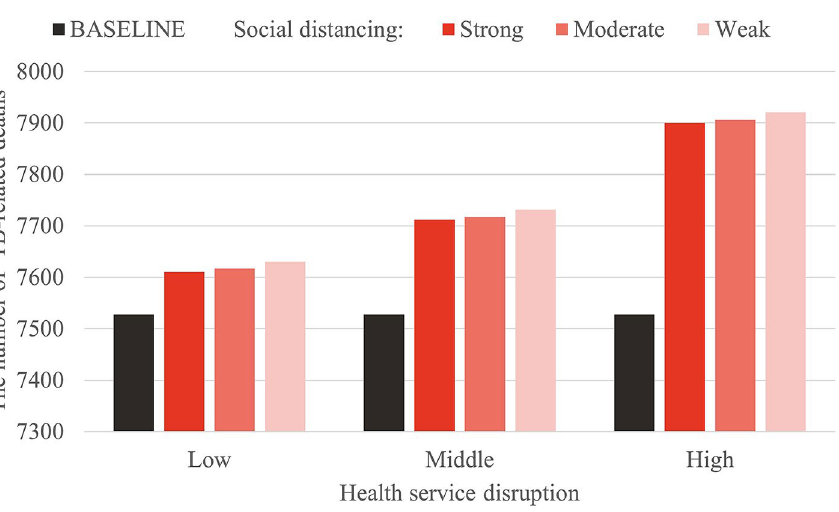
Figure 7. Cumulative number of TB-related deaths from 2020–2025 under each scenario of social distancing and health service